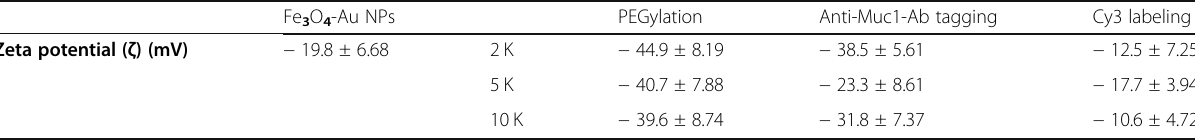
Table 1 Zeta potential measurements performed with bare Fe 3 O 4 -Au core-shell NPs, PEGylated NPs, nanobody-tagged NPs, and dye-labeled NPs at pH 7.4, presented as the mean of five runs ± SD Fe 3 O 4 -Au NPs PEGylation Anti-Muc1-Ab tagging Cy3 labeling Zeta potential ( ζ )